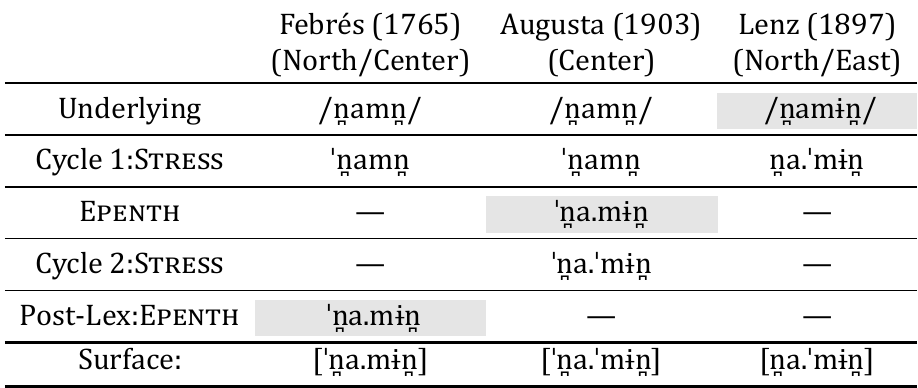
Table 16: Dialectal (and historical) differences in the position of stress in disyllabic nouns with (cid:976)inal syllable interconsonantal [ɨ] (cid:24) [ə] (Example: [n̪amɨn̪] ‘foot’)